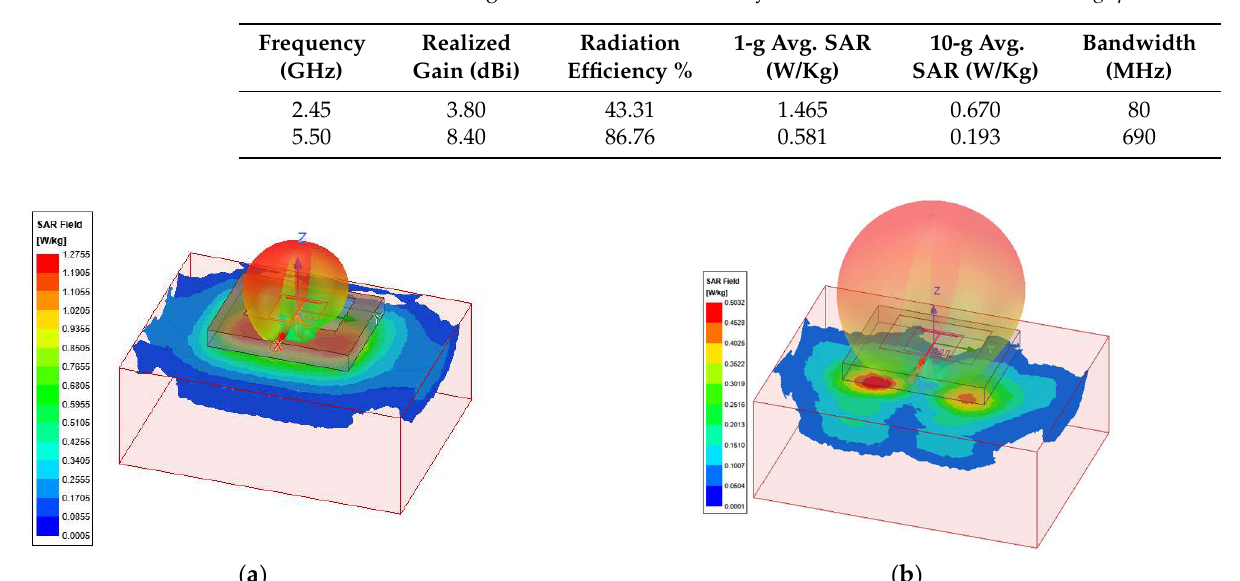
Table 3. SAR and antenna gain and bandwidth summary for h = 4 mm substrate and air − gap = 2 mm.